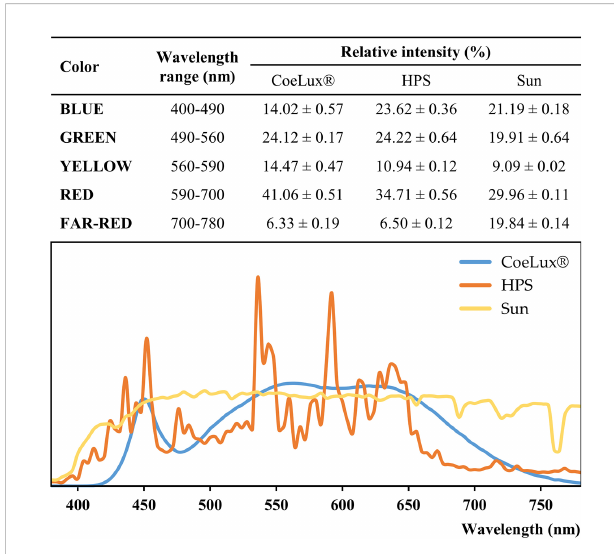
FIGURE 2 Spectra color composition and spectra curves of the CoeLux ® (blue), the HPS (orange), and the Sun (yellow) light types. Spectra measurements were collected in the range between 380 nm and 780 nm for each light type. To allow the comparison, photon counts measurements were normalized on the luminance of the respective spectrum. In the table, the sum of normalized photon counts was calculated for each color interval and reported in the form of relative intensity ± standard deviation. Spectra curves represent the mean of 8 different measurements